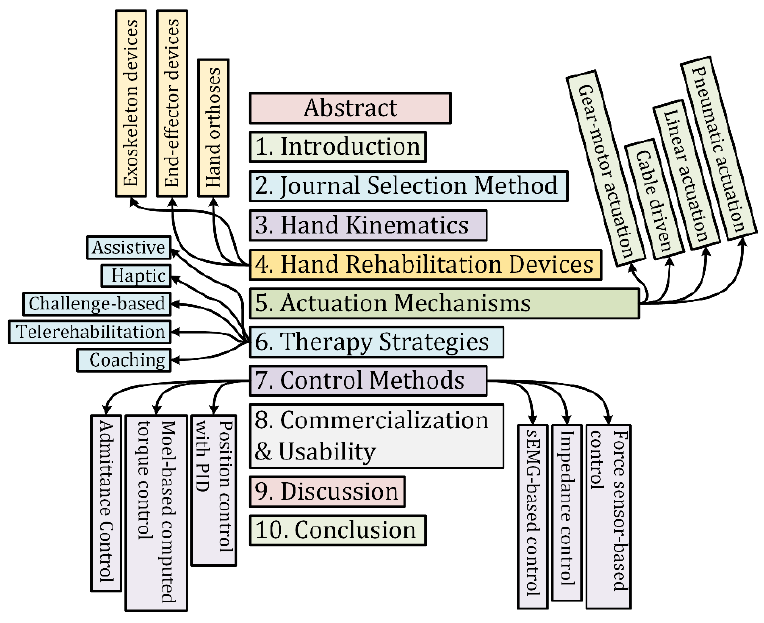
Figure 1. Organization of the